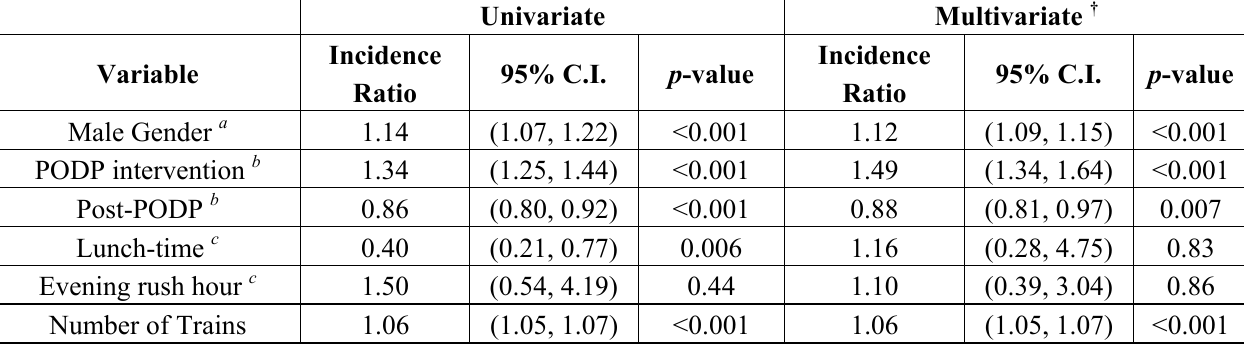
Table 2. Univariate and multivariate results of the Generalized Estimating Equation (GEE) model. The incidence ratio and the respective 95% confidence interval are shown.